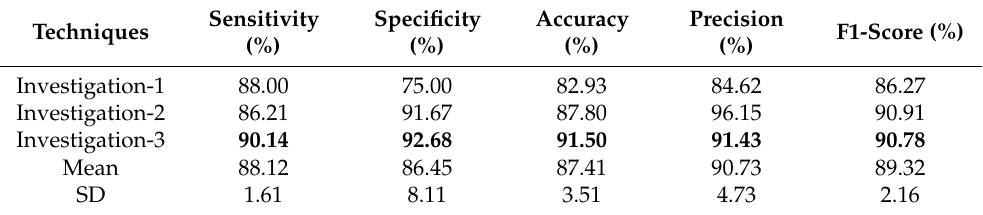
Table 14. Summary of best statistical combination achieved using the proposed